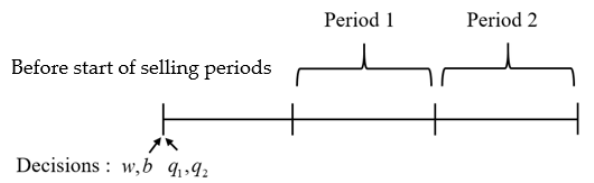
Figure 1. Timeline of decision making in Model 1.